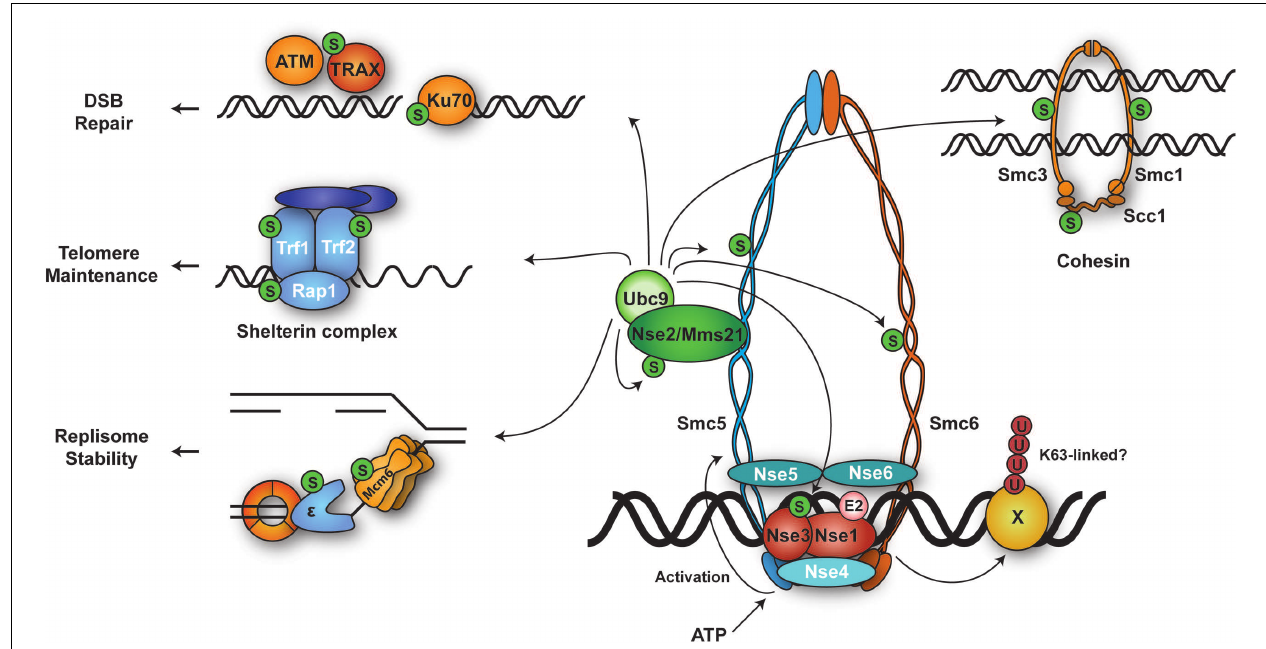
FIGURE 5 | Ubiquitylation and SUMOylation targets of Smc5/6 and their associated processes. The Smc5/6 complex harbors SUMO ligase (Nse2) and ubiquitin ligase (Nse1-Nse3) subunits. DNA binding stimulates the ATPase domains at the globular heads of Smc5/6, inducing a conformational change in the coiled-coil region of Smc5 that activates the SUMO E3 activity of Nse2. Smc5/6 likely selects its ubiquitylation and/or SUMOylation targets at relevant loci where the complex is recruited.